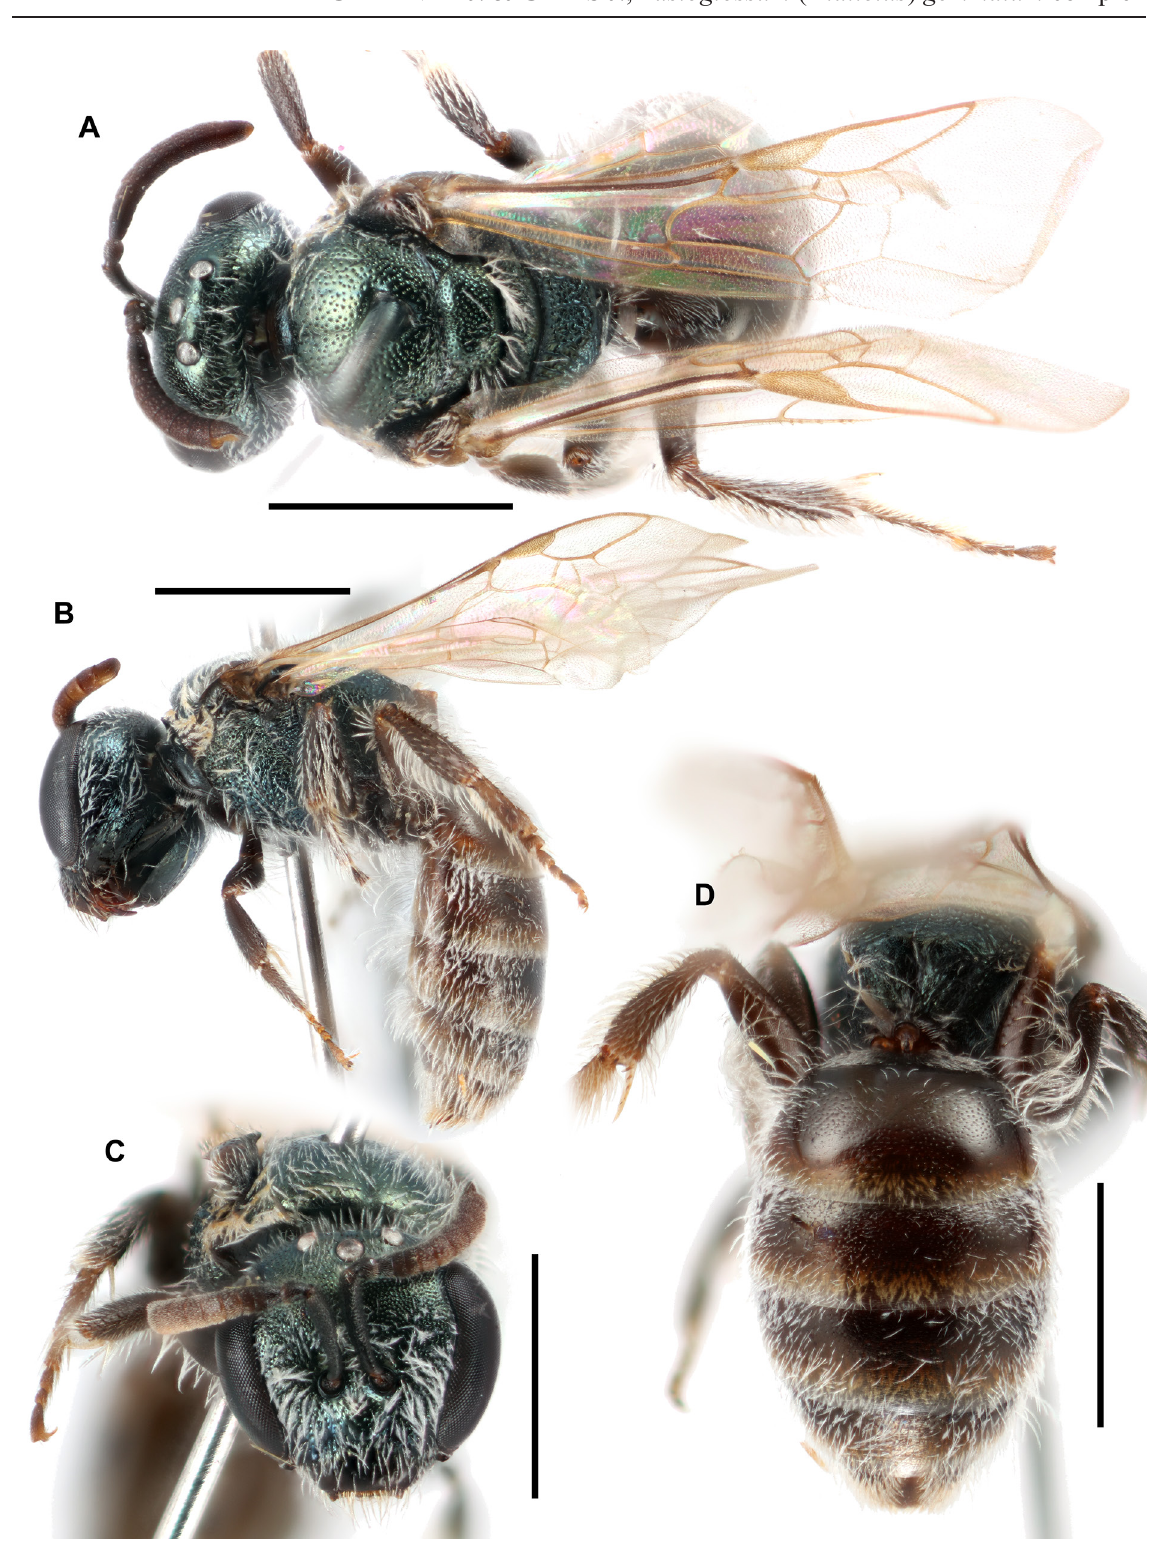
Fig. 21. Lasioglossum ( D .) eremum sp. nov., ♀ (BBSL1070450). A . Dorsal habitus. B . Lateral habitus. C . Face. D . Metasoma and propodeum. Scale bars = 1